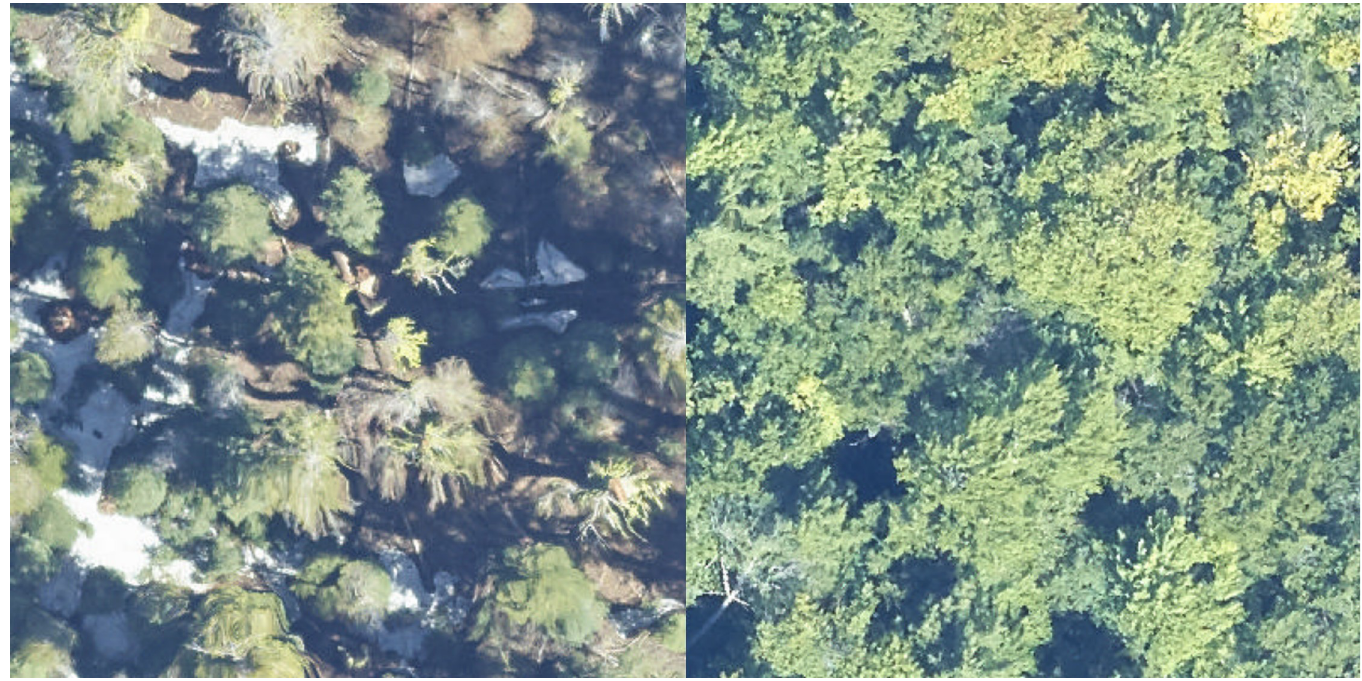
Fig 1. A 40m x 40m evaluation plot of RGB data from the Teakettle Canyon (TEAK) NEON site (left) and Bartlett Experimental Forest, New Hampshire (BART) (right).